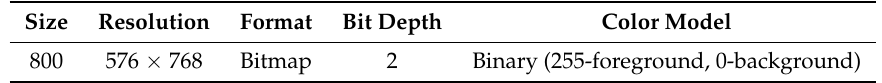
Table 3. Overview information of a the mask set corresponding to the tongue images in Figure